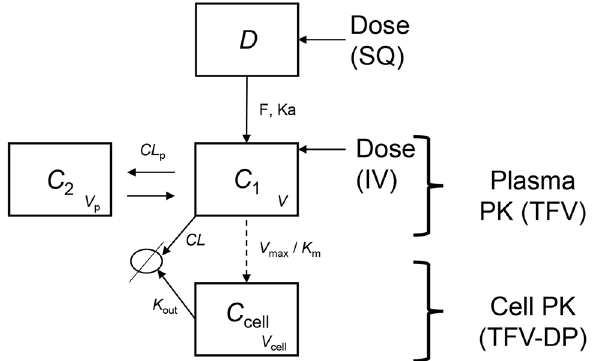
Figure 7. Pharmacokinetic model for plasma TFV and intracellular TFV-DP in mice, based on the model reported by Duwal et al. 44 . IV dosing occurs in the C1 compartment, SQ and implant dosing occur in the D compartment (dosing reservoir). The release rate into the D compartment is assumed instantaneous following SQ dosing, but is governed by the actual implant TAF release rate in the case of implant administration. The fraction of TAF metabolized to TFV is assumed to be 100%. V , volume of distribution of the central compartment; CL , total body clearance; V p , volume of distribution of the second compartment; CL p ,